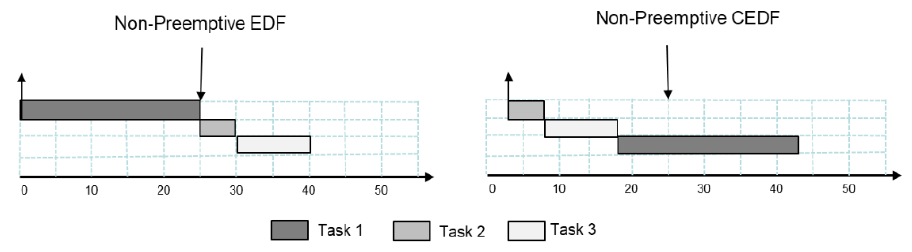
Figure 3. C-EDF Scheduling Example.